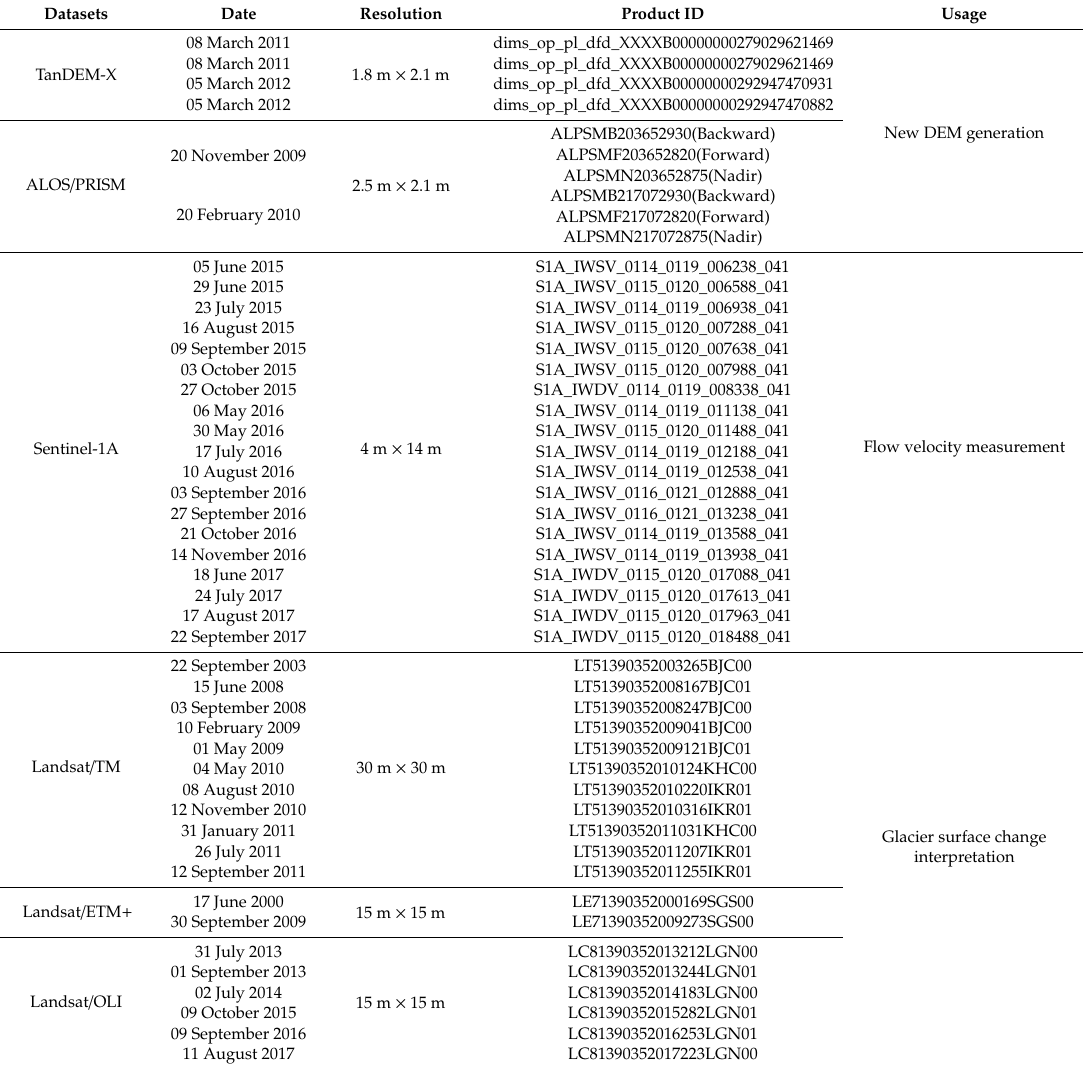
Table 1. Datasets used in this